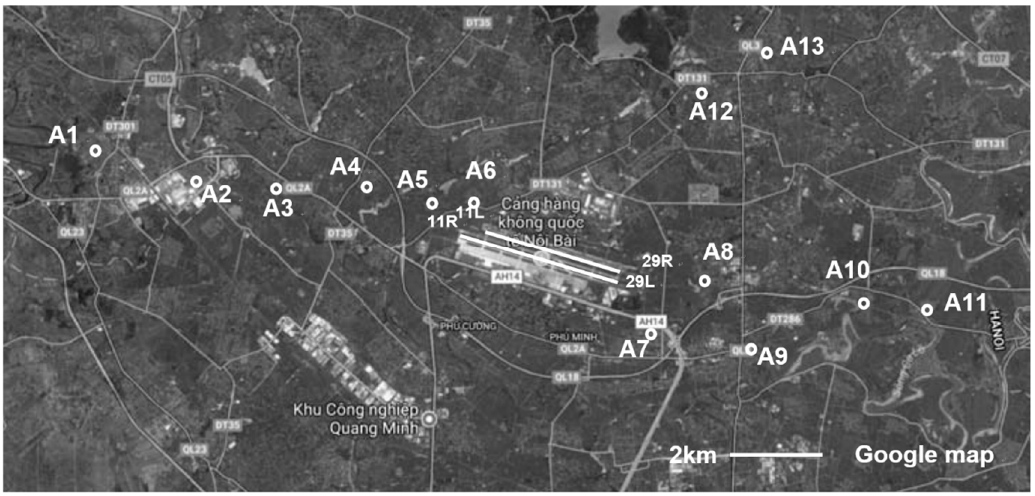
Figure 1. Map of all surveyed sites.